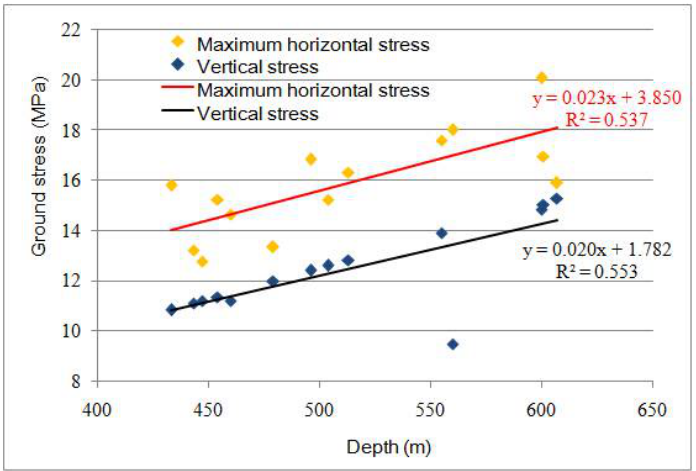
Figure 2. Correlation between ground stress and depth in the research area.